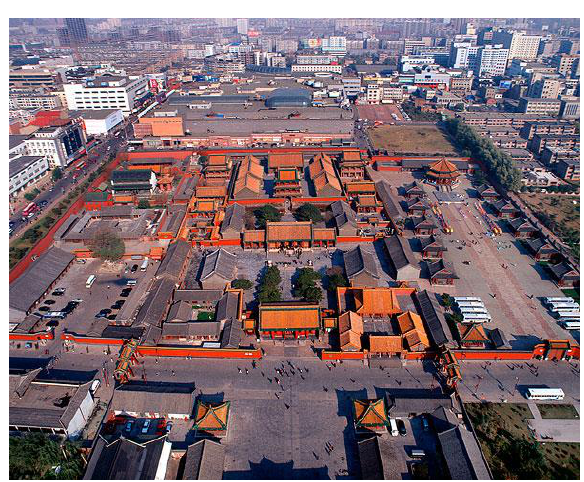
Figure 1.The aerial view of Mukden Palace